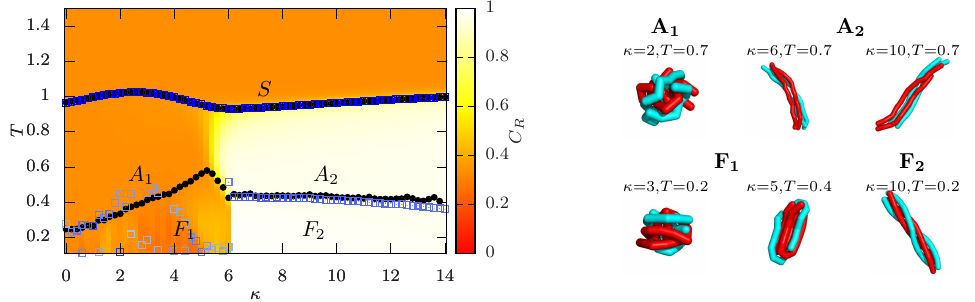
Figure 5. Structural phase diagram of M = 4 polymers of length N = 13 in the temperature-stiffness plane. The color map encodes the end-to-end correlation parameter from uncorrelated ( C R = 1/3, orange) to correlated ( C R = 1, white). Black dots denote peaks in the specific heat; blue squares indicate peaks in the phase-separation parameter with signal strength encoded in the color intensity. From the solute (S) regime, the polymers aggregate into amorphous aggregates ( A 1 ) or polymer bundles ( A 2 ) for low or high bending stiffness, respectively. At even lower temperatures, more ordered structures occur ( F i ). Representative conformations are shown next to the